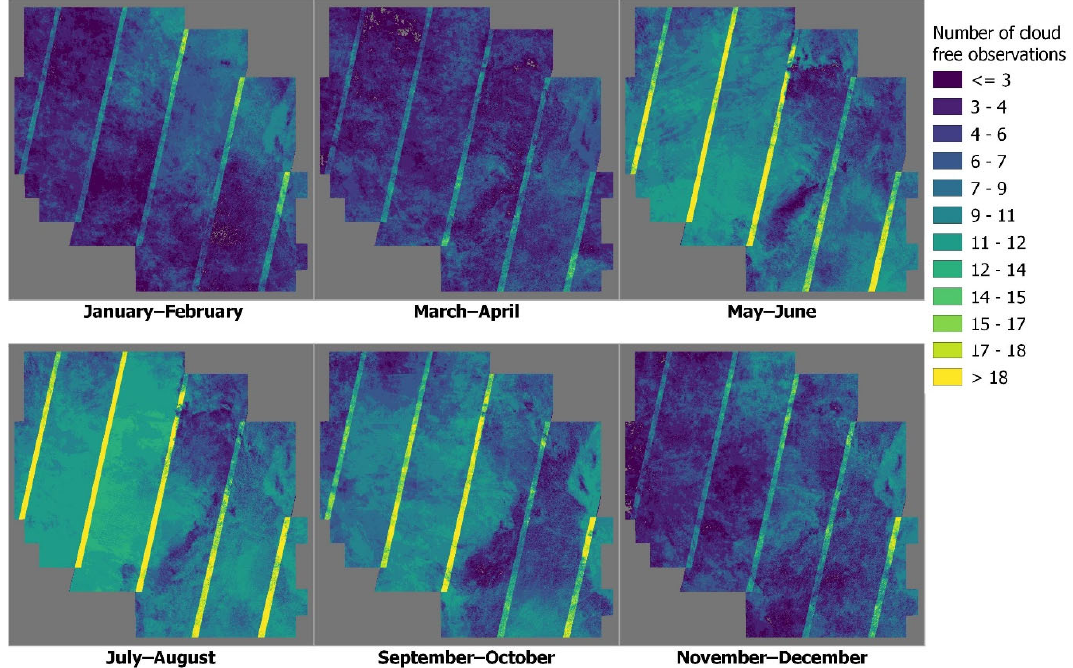
Figure 3. NDVI bi-monthly compositing—number of cloud free